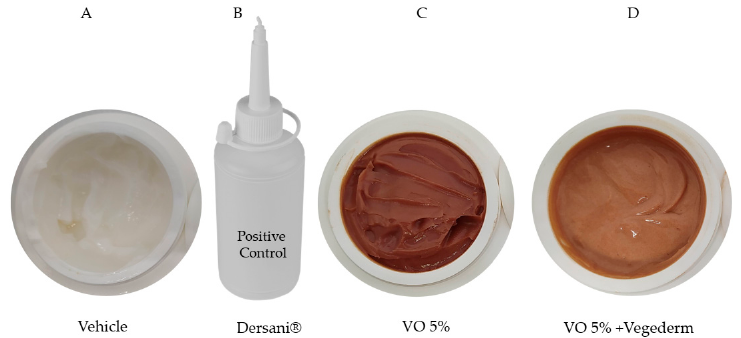
Figure 2. Four types of creams were formulated in this study. Vehicle ( A ), Dersani ® ( B ), VO 5% (based on the pilot study) ( C ), and the second incorporation of VO 5% into vegetable oil blend (Vegederm) ( D ).